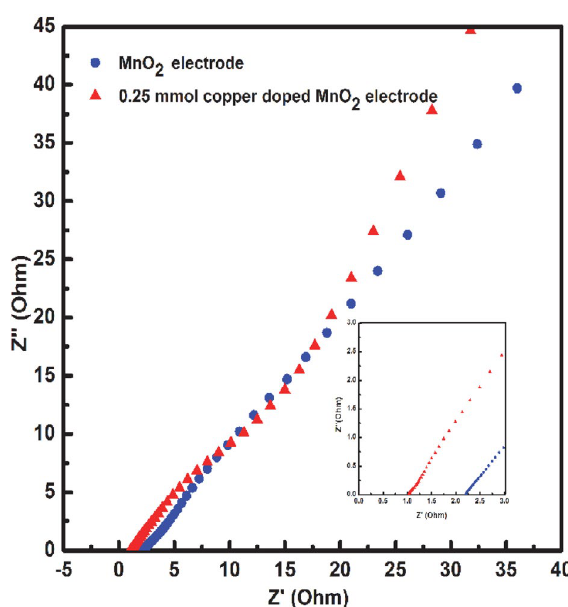
Fig. 10. Nyquist plots of the as-prepared electrodes.